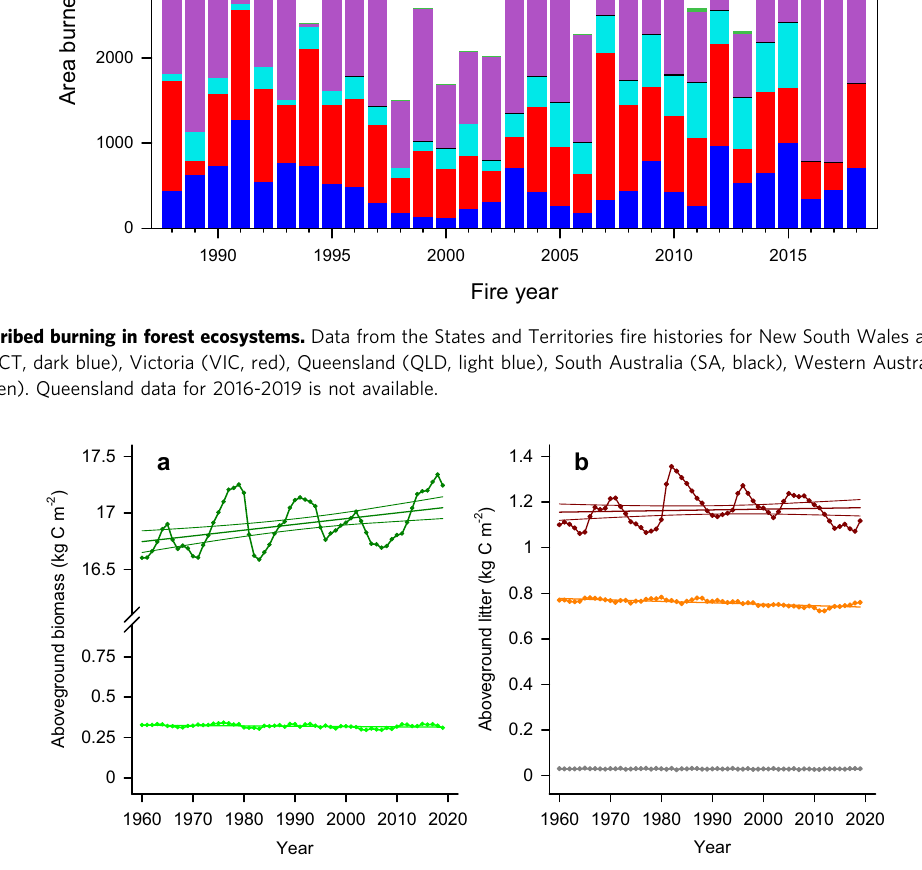
Fig. 8 Modelled aboveground biomass and litter fractions of forested areas. a Aboveground woody biomass (dark green, with 95% con fi dence interval) and leaf biomass (light green), and ( b ) litter fractions of forests derived from BIOS-CABLE with varying observed CO 2 and climate. Coarse woody debris (dark red, with 95% con fi dence interval), fi ne litter (orange), very fi ne litter